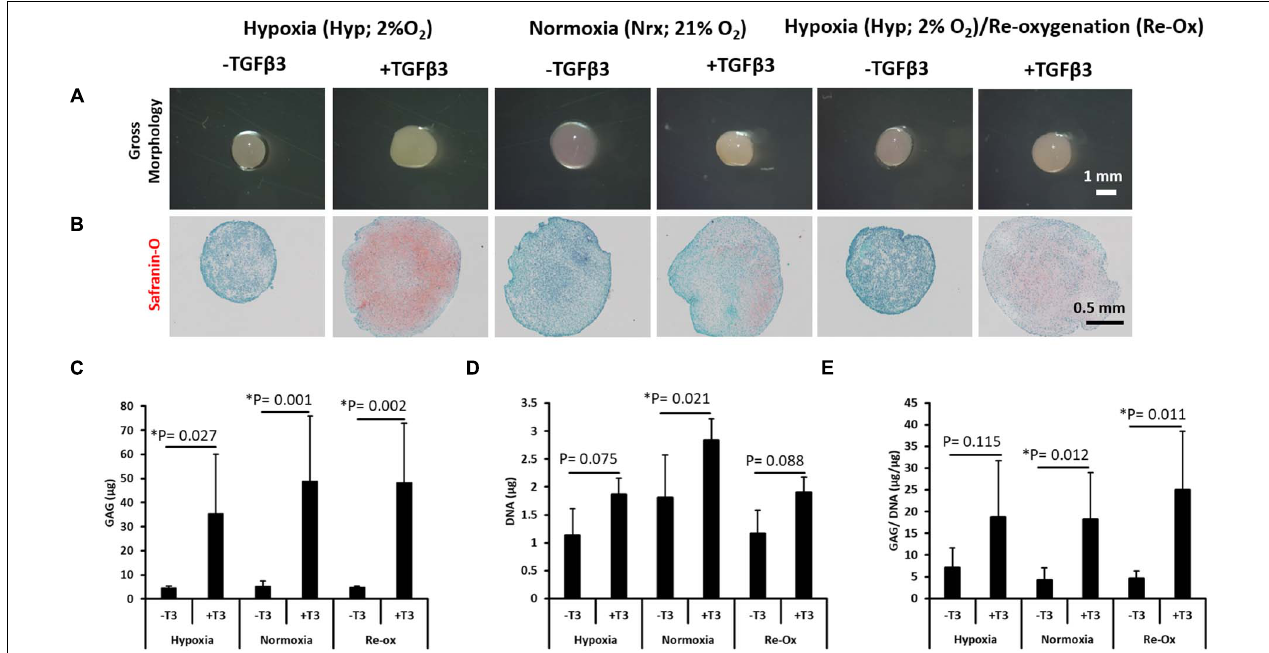
FIGURE 1 | Gross morphology of IFP-MSC pellets after 21 days of in vitro culture; Safranin O histochemical staining and biochemical assay for GAG and DNA content. (A) Gross morphology of pellets, (B) Safranin O staining, (C) total GAG content, (D) total DNA content, and (E) GAG/DNA content. Comparing pellets for seven donors done in duplicates ( N = 7, n = 14 per experimental group) after 21 days of in vitro culture under six different conditions. Bar data are mean ± standard deviation. Statistical comparisons were based on Kruskal–Wallis test between without TGF β 3 (i.e., –T3) and with TGF β 3 (i.e., +T3) groups within an oxygen tension group. ∗ Indicates statistical difference between compared groups with p -value <